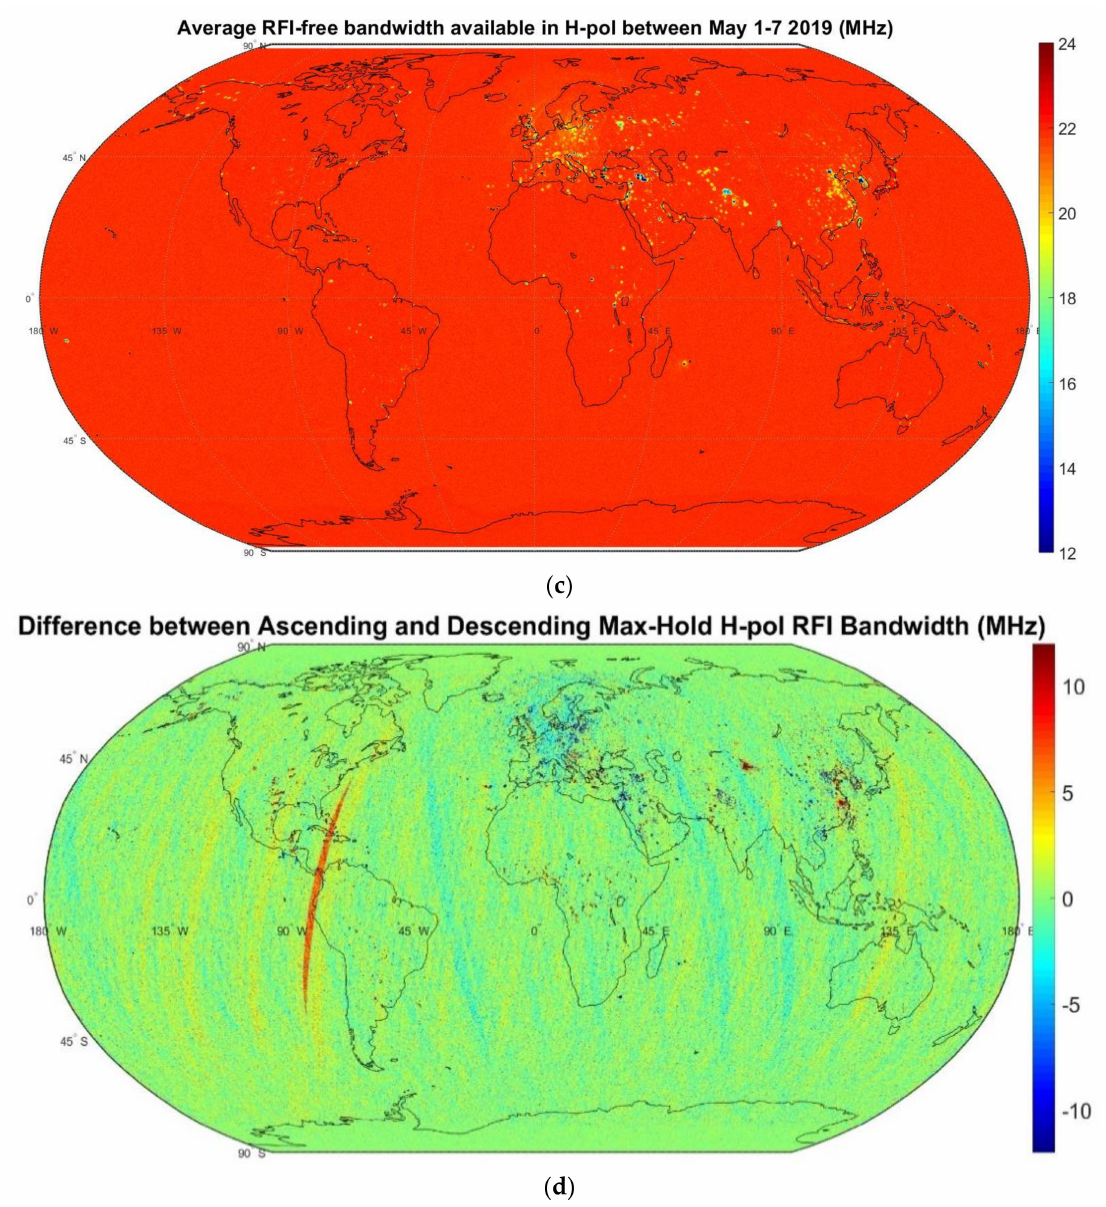
Figure 4. ( a ) Maximum RFI bandwidths, ( b ) average RFI bandwidths, ( c ) average RFI -free bandwidth availability (in MHz), and ( d ) difference in maximum RFI bandwidth between ascending and descending orbits within the SMAP band in H-pol between 1 and 7 May 2019 on 0.25 ◦ × 0.25 ◦ gridded maps. The large orange region in ( d ) is due to missing data in descending